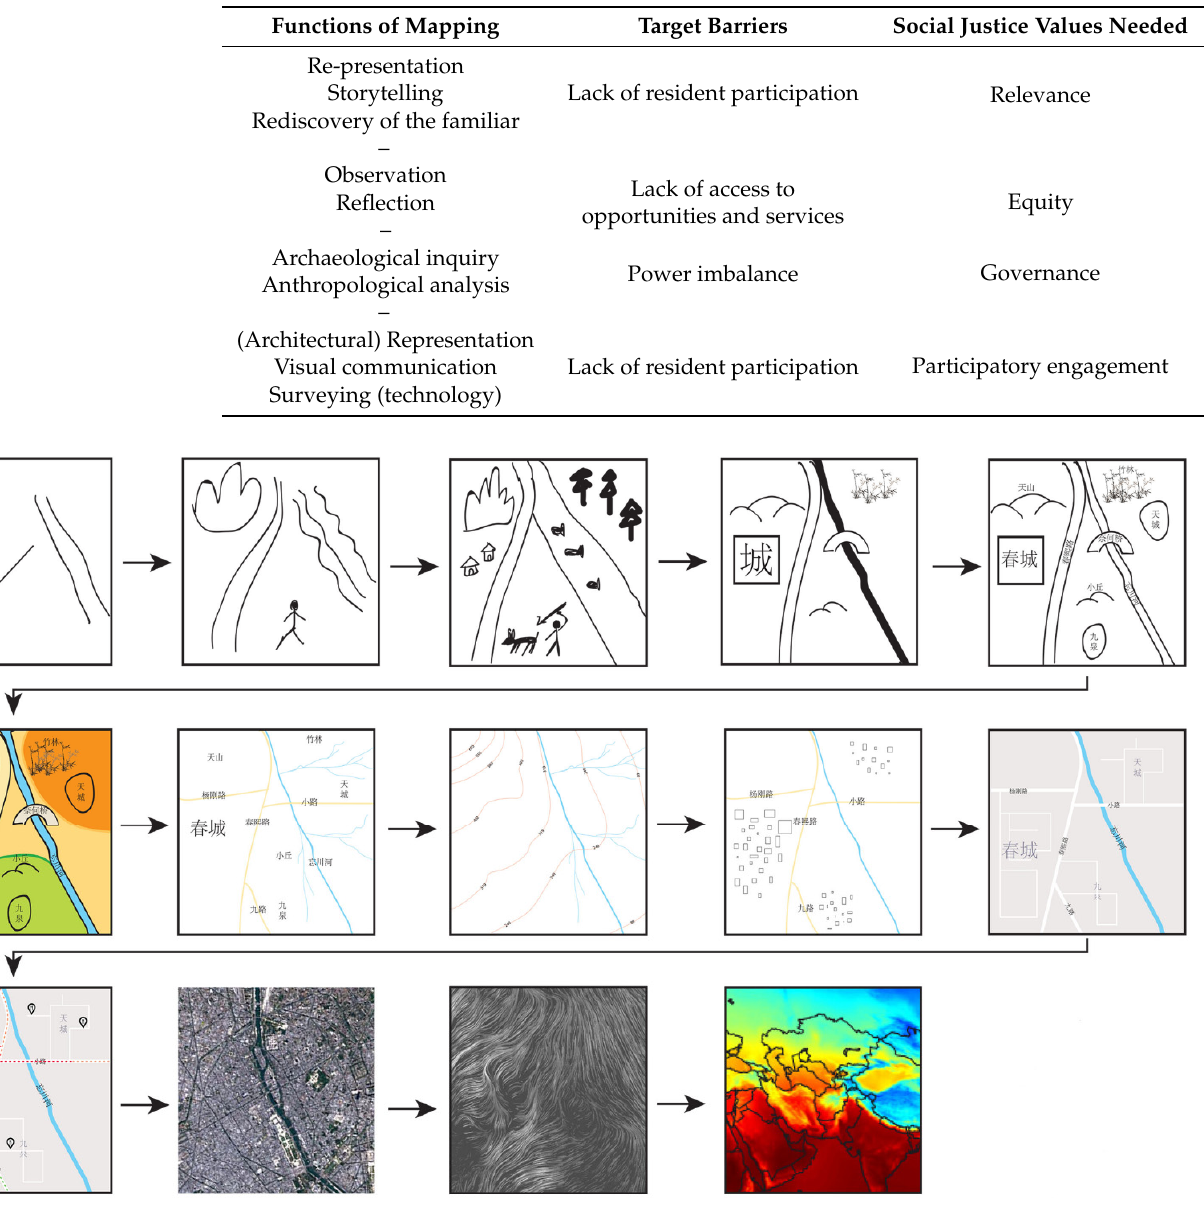
Table 1. Mapping applicability.